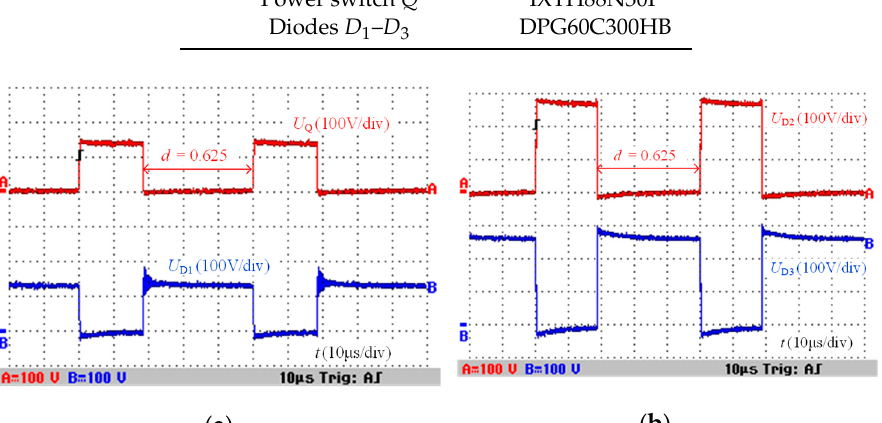
Figure 6. The experimental prototype of the proposed converter.